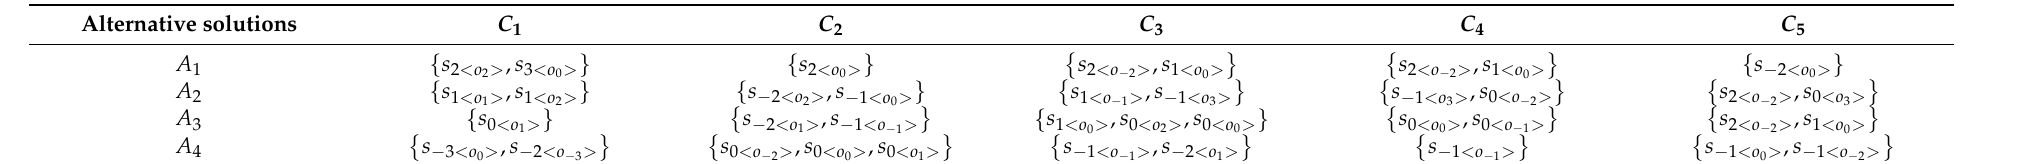
Table 2. The normalized DHHL decision matrix H 1